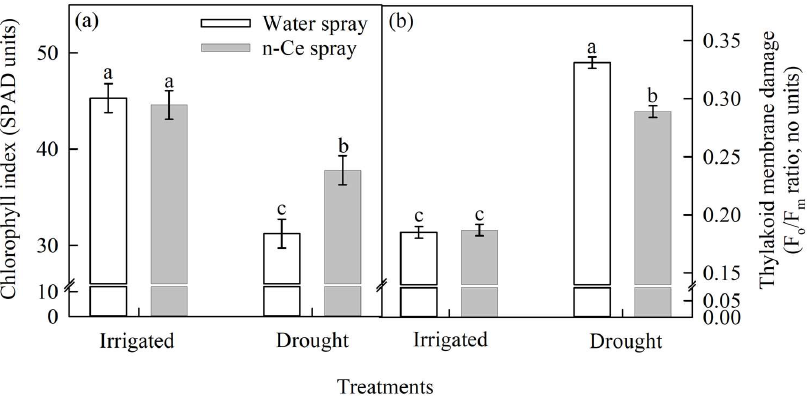
Figure 3. Effect of drought and foliar spray of nanoceria on ( a ) chlorophyll index (SPAD units) and ( b ) thylakoid membrane damage (Fo/Fm ratio) in mungbean (field experiment). Each value is the mean ± SD of 45 independent measurements (3 replicates × 5 plants in each replicate × 3 observation times). Means with different letters are significantly different at p ≤ 0.05.